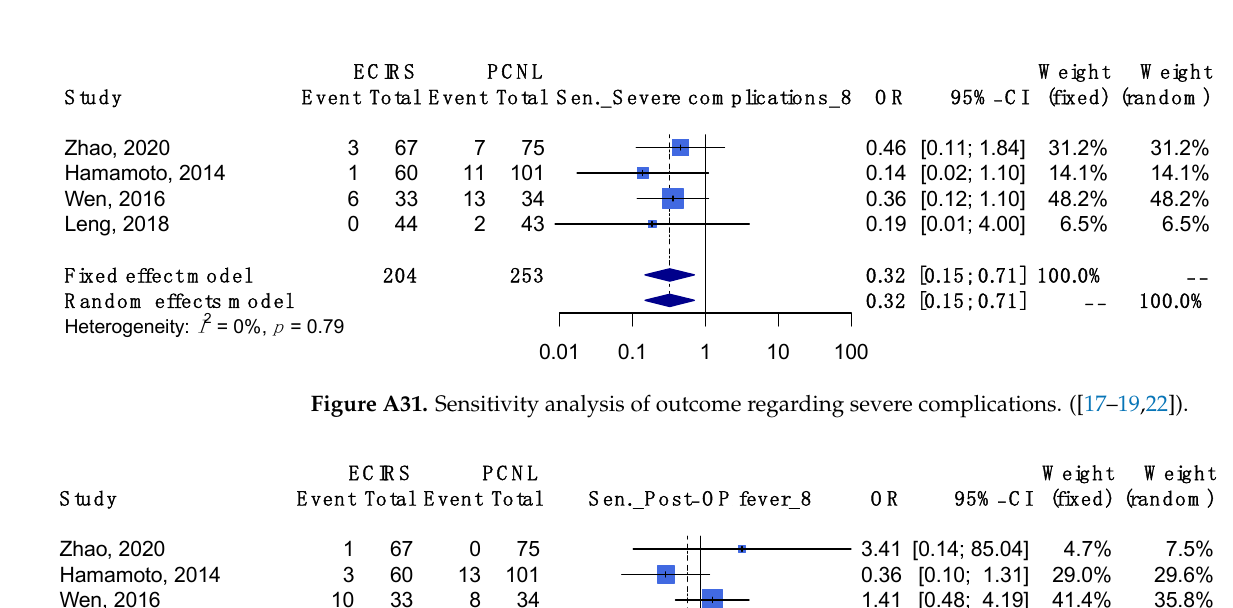
Figure A30. Sensitivity analysis of outcome regarding overall complications. ([17–19,22])